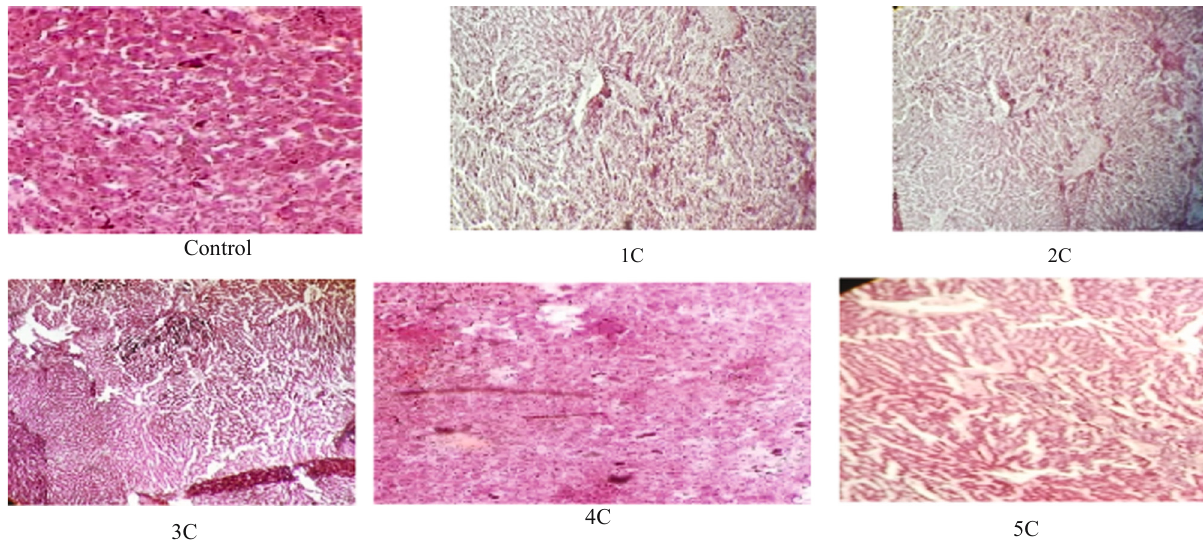
Figure 1: E ff ect of thiourea derivatives on liver ( 1 , 2 , 3 , 4 , and 5 indicate the respective thiourea derivative. C indicates the amount of dose given which is 1.5 mg/kg body weight. Livers were collected at day 30 of the experiment )